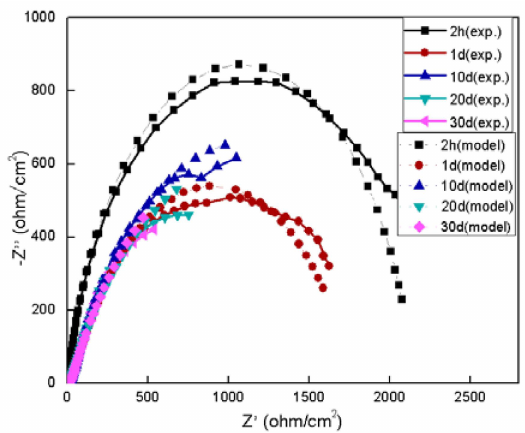
Figure 6. The Nyquist of the Ni 2 Al 3 coating in different soaking times. The symbols delegate the experimental results, and the lines delegate the model results.